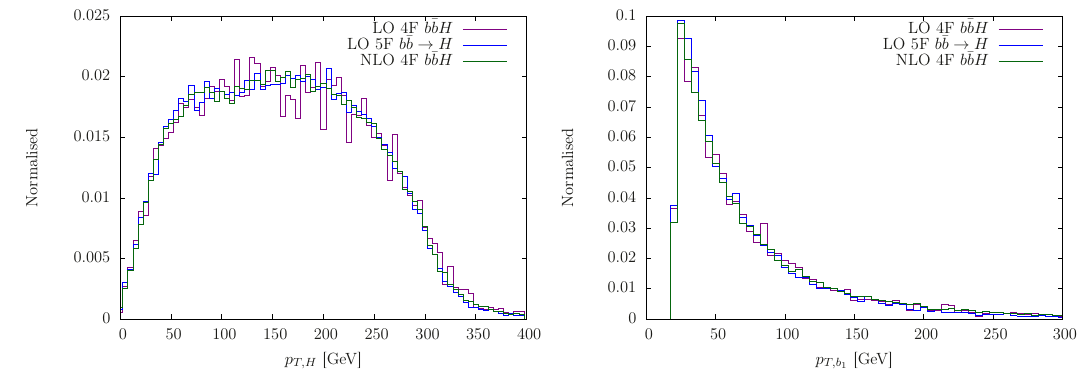
Figure 15. The normalised distributions of p T,H and p T,b a comparison between LO 4F, 5F b ¯ bH and NLO 4F b ¯ bH